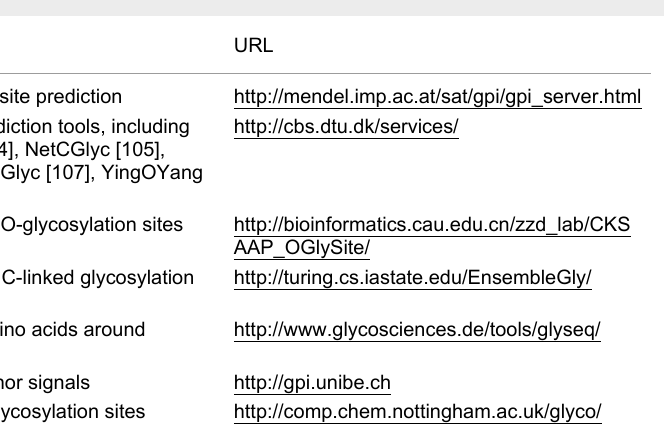
Table 5: Prediction and analysis of glycosylation